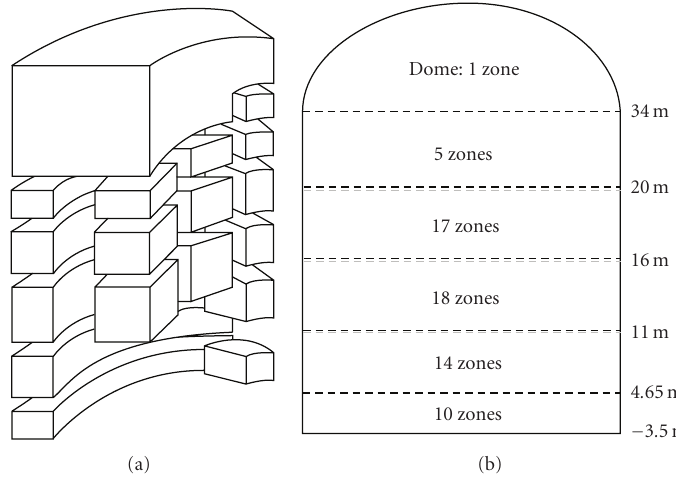
Figure 4: View of PWR 900 Astec nodalisation.